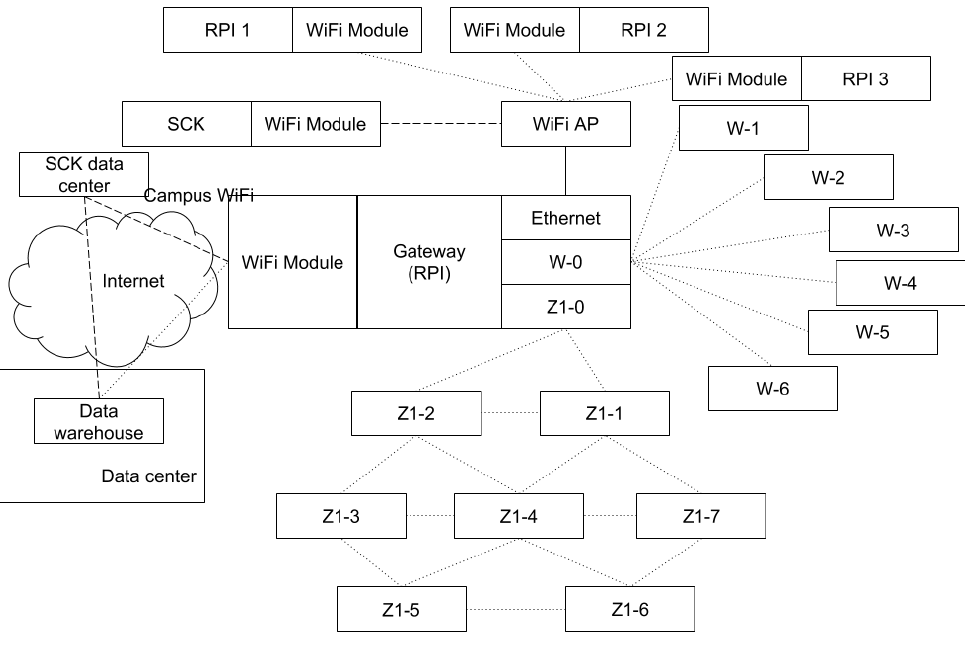
Figure 1. Technical schema of the testbed.